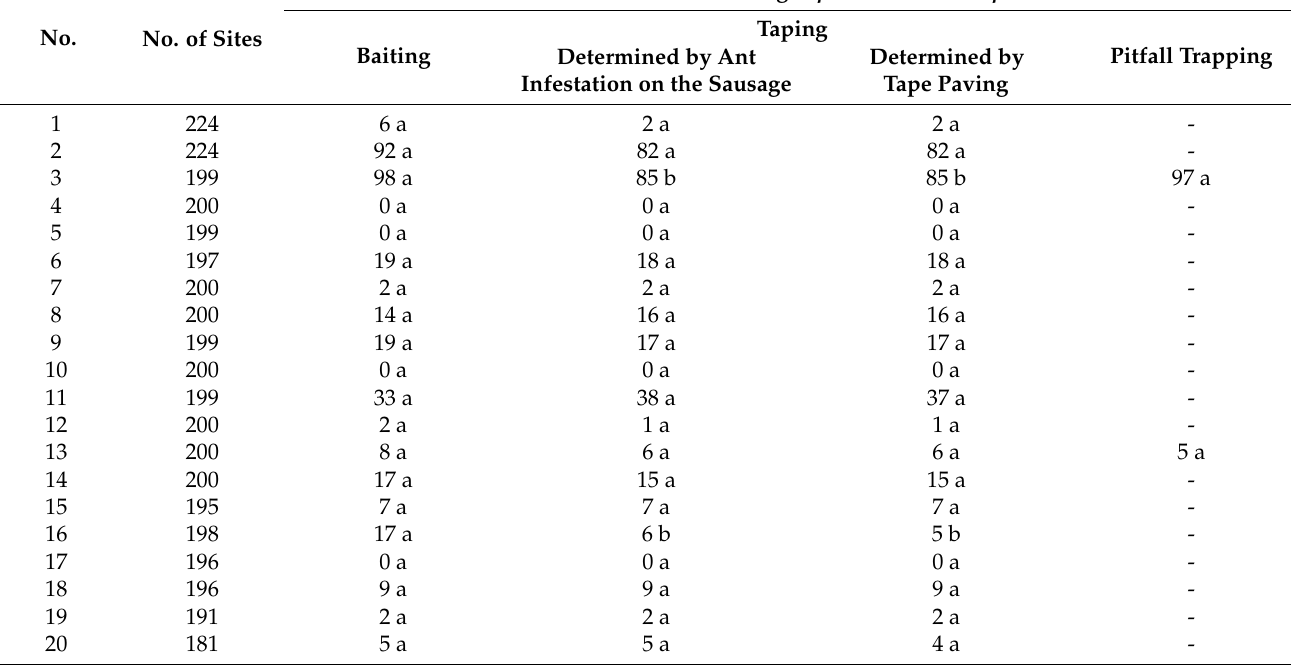
Table 2. Number of monitors (bait, tape, or pitfall trap) detecting Tapinoma melanocephalum at each location. “-” indicates pitfall traps were not tested in the location. Different letters within the same row indicate significant differences ( p < 0.05). Statistical results are shown in Supplementary Material: Table S4.